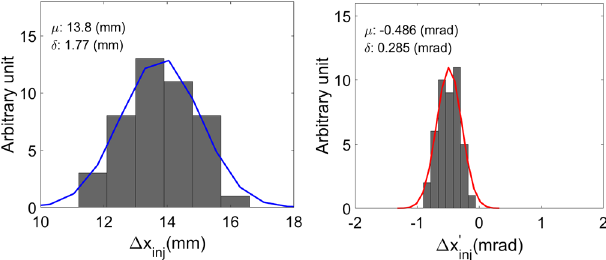
FIG. 9. The statistics of 11 beam tests in the machine study.